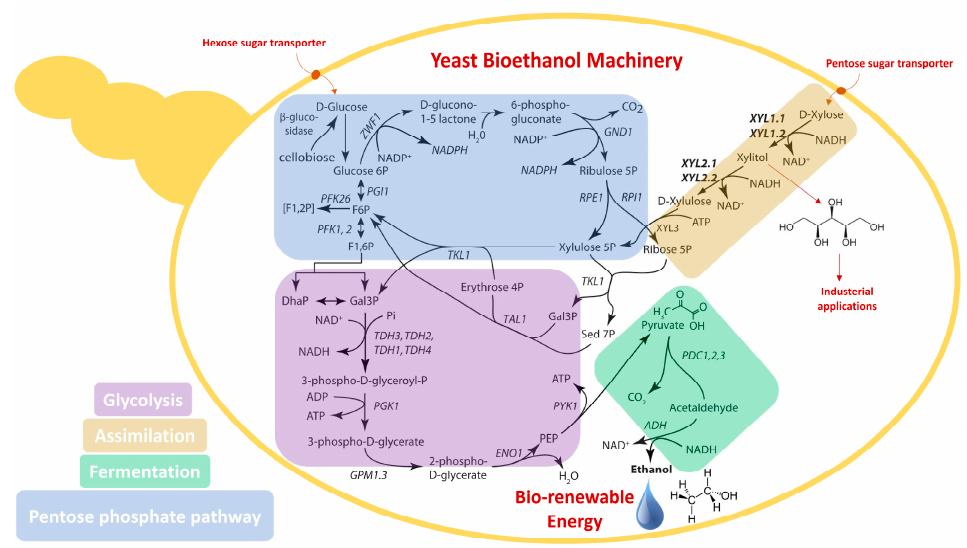
Figure 4. Model for bioethanol production using yeast fermentation machinery.